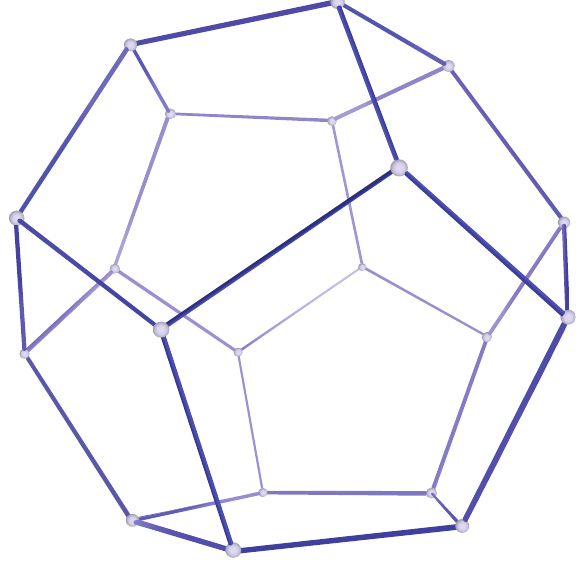
Figure 1: The regular